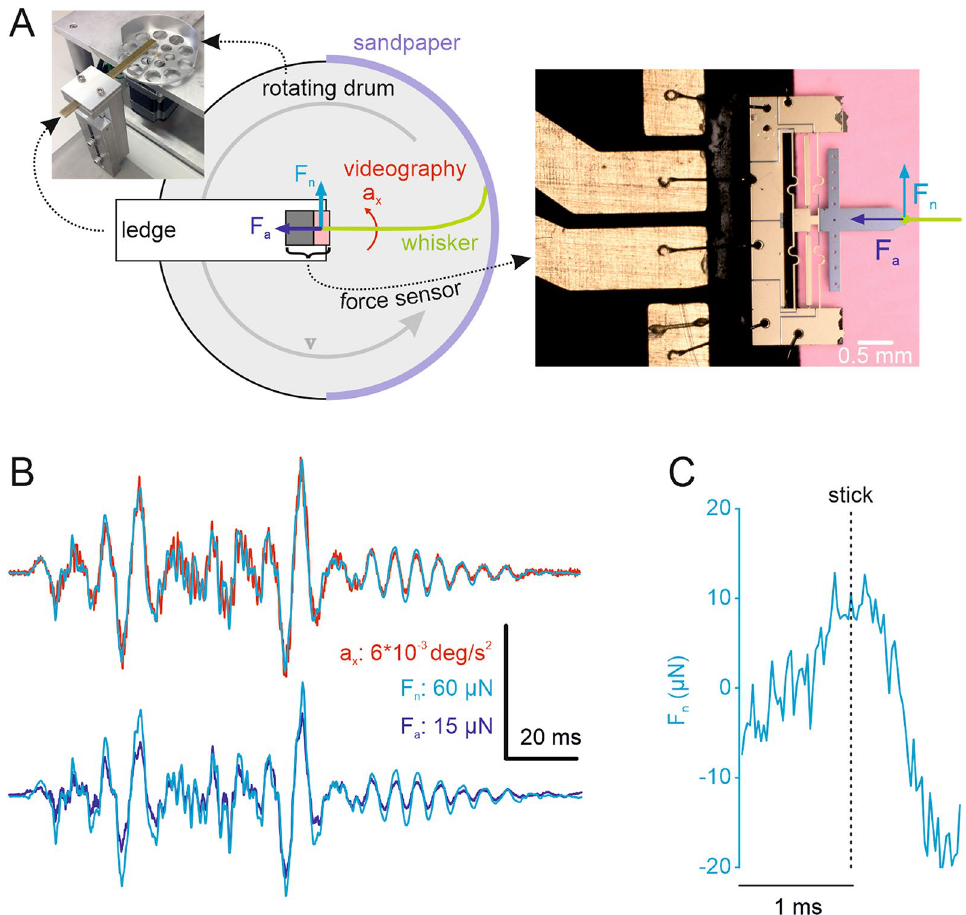
Figure 4. Micro-force measurement at the whisker base. ( A ) Left inset: Photograph of the measurement set-up. The sensor was mounted on an immobile ledge directly above the rotation axis of a rotating drum. The drum was perforated to save weight and contained a wall to fix the sandpaper. Centre: Schematic of measurement set-up. The whisker (green) was mounted on the sensor (dark grey and pink), and brought in contact with the sandpaper (violet), which in turn was rotated by the drum (grey arrow). Two measurements were performed. First, the forces in the plane of whisker movement ( F n , F a ) were directly measured by the piezoresistive sensor (right inset). Second, the lateral acceleration at the base (s = 3 mm) ( a x ) was assessed by videography (cf. Fig. S1). ( B ) The top graph plots a x (red) on top of F n , the bottom one plots F n and F a . Acceleration is in excellent correspondence to the forces acting on the base. ( C ) Average normal force triggered on stick events. F n builds up during sticks (as well as F a , not shown). Compare with the parallel increment of moment M na as calculated from curvature measurements (Fig.